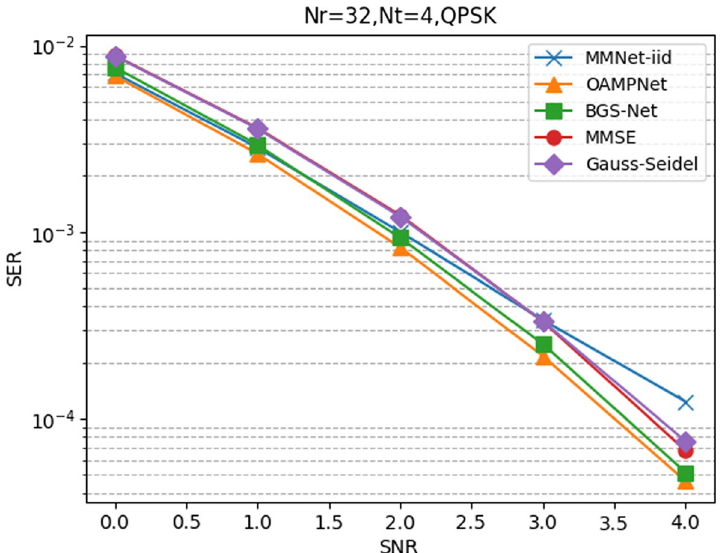
Fig. 13 SER performance comparison of different algorithms under N t = 4,N r = 32 , QPSK, SAUE system